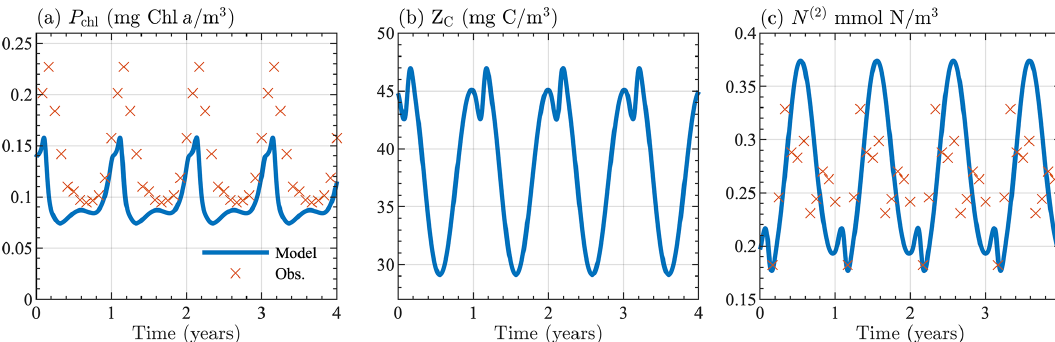
Figure B1. Seasonal cycle of surface (a) chlorophyll, (b) zooplankton carbon, and (c) nitrate from the 0-D test of BFM17. Results are shown for the last 4 years of the 10-year simulation. Panels (a) and (c) show monthly averaged values taken from the observational data described in Sect.